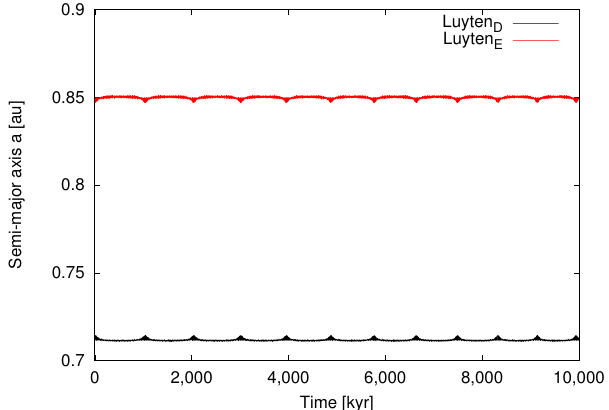
Figure 5. Case 4 ( e D = 0, e E = 0). Time evolution of the two outer planets over 10 Myr. While this is a stable configuration, it is not realistic to expect that any system will have perfectly circular orbits.